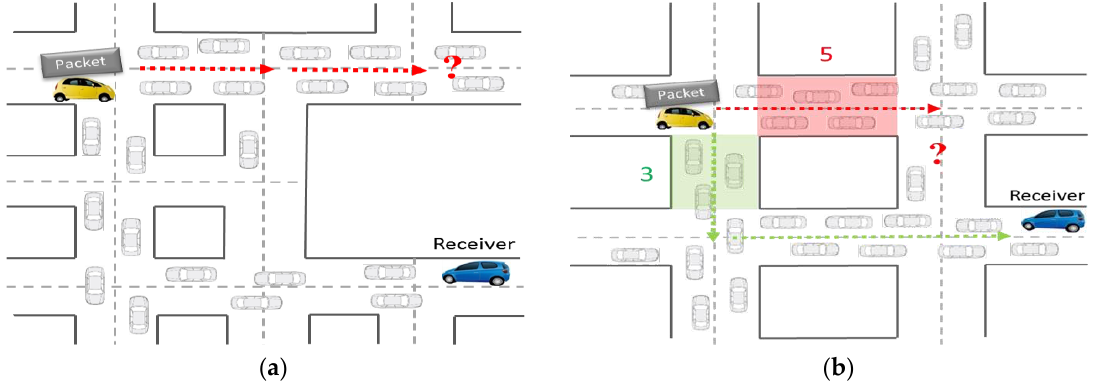
Figure 3. Issues when only the next road segment is considered where the red dotted lines show the wrong selections and the green dotted line shows the best choice: ( a ) move to a road away from the receiver; and ( b ) connect to a sparse road (marked by the question marks, respectively).